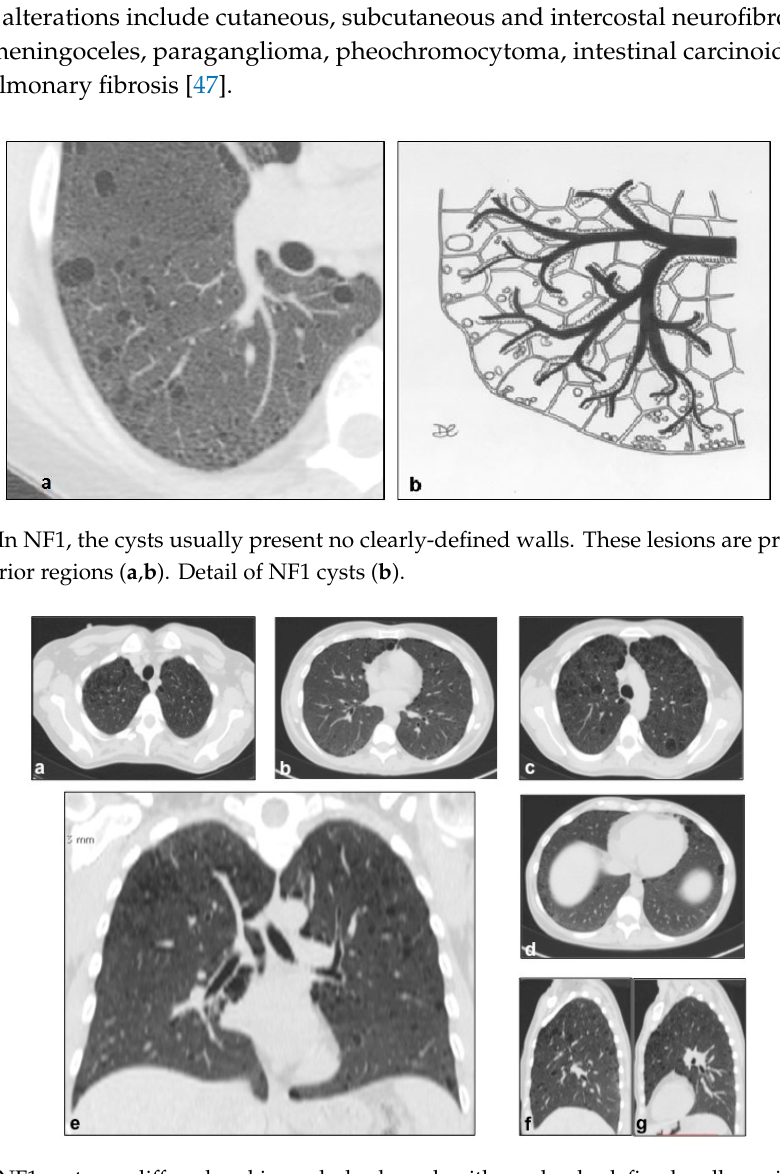
Figure 13. NF1 cysts are diffused and irregularly shaped, with no clearly-defined walls, mainly located in the upper lobes, symmetrically ( a , b , c , d ). In addition to cysts, ground-glass opacities